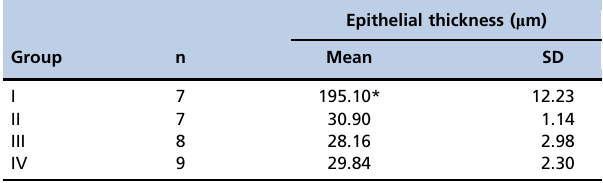
Table 1 - Means and standard deviations of the vaginal epithelium thickness of female rats in persistent estrus (Group I, positive control) and the castrated rats in Groups II (negative control), III and IV (experimental groups) treated with gels with vehicle and